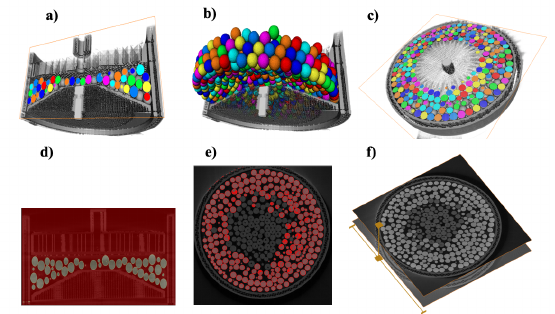
Figure 2. Segmented 3D images of spherical teflon particles (4.7 mm) in the shear cell described in Fig. 1. Colors represent indi- vidual labeled grains. (a) cross section of the particles inside a cone-plate shear setup. (b) a full 3D view of the particles. (c) Segmented spherical particles, top view. (d) 2D section from scanning of our second material after rotation. (e), (f) Teflon and nylon grains show up with a di ff erent gray level, as they have a di ff erent x-ray absorption coe ffi